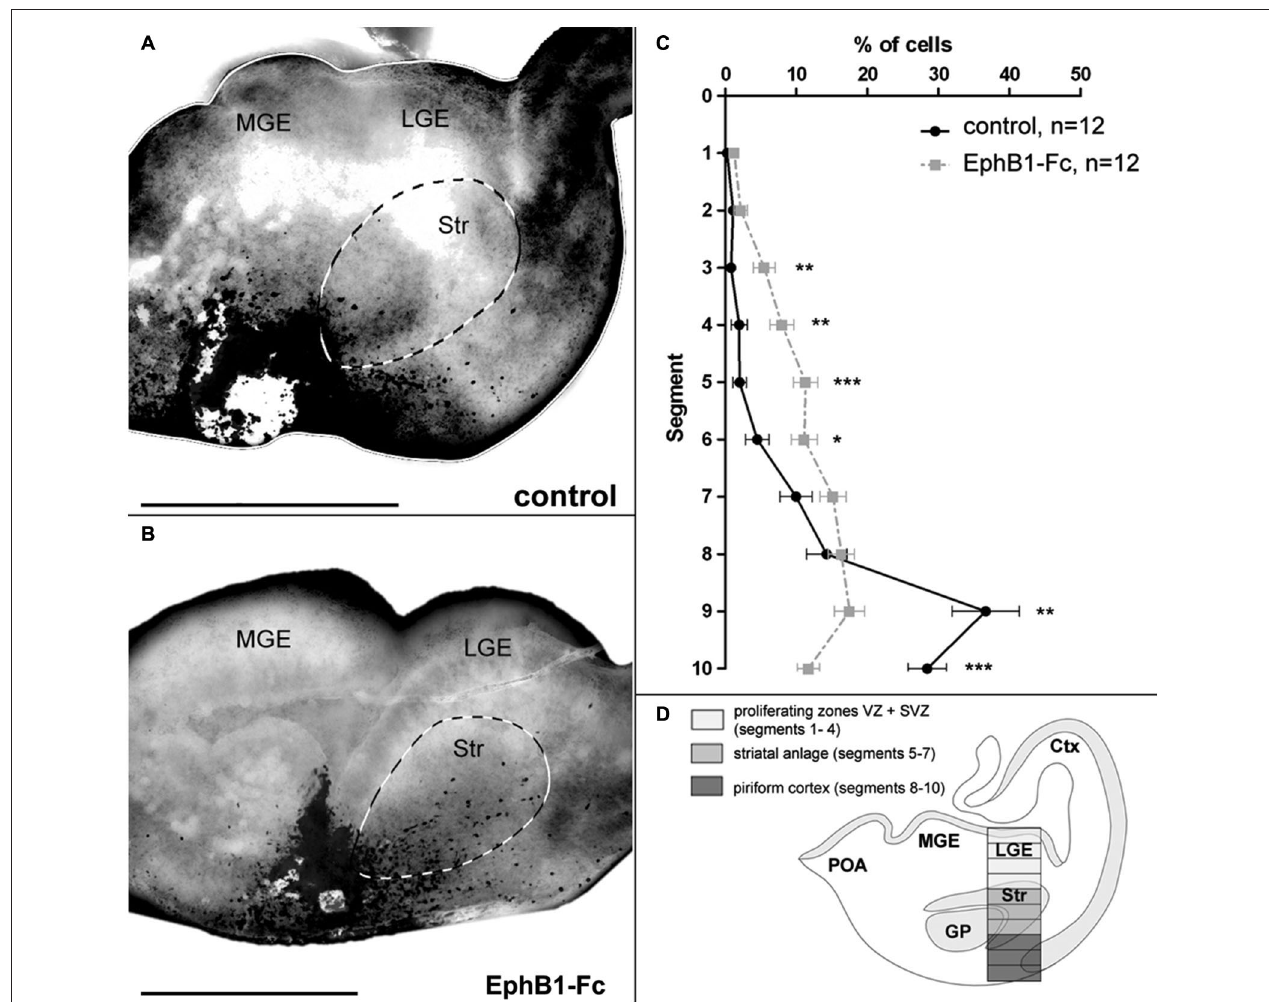
application of 5 µ g/ml EphB1-Fc. ( D ) Schematic view of a coronal brain slice as used for the grafting experiments, illustrating the analyzed area which was horizontally divided into 10 equal segments, with segment 1–4 representing the proliferating zones, segments 5–7 the striatum and segments 8–10 the piriform cortex. Lateral is right and medial is left. GP, Globus pallidus; LGE, lateral ganglionic eminence; MGE, medial ganglionic eminence; SMS, superficial migratory stream; Str, Striatum. n = number of analyzed slices. Error bars indicate SEM. One-way ANOVA * p < 0.05, ** p < 0.01, *** p < 0.001. Scale bars: 500 µ